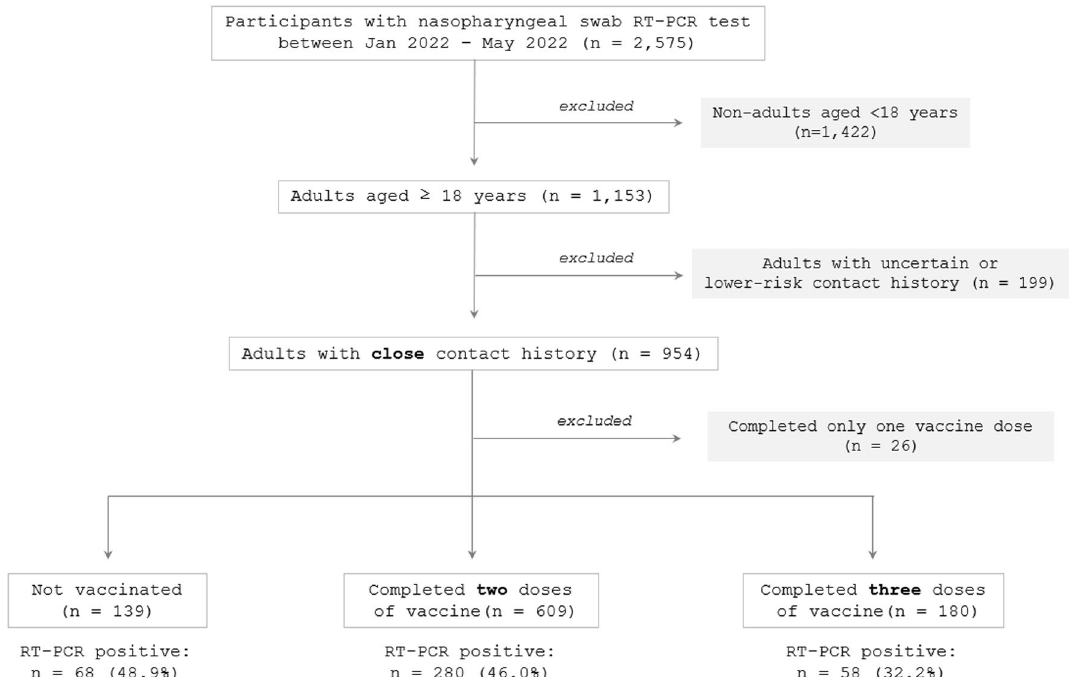
Figure 1. Flow diagram of the study design. Among the overall individuals tested by reverse transcription- polymerase chain reaction (RT-PCR) test using nasopharyngeal swab samples at a large screening test center in Japan between January and May 2022, (1) adults aged < 18 years, (2) those without a certain contact history, (3) those who had completed only one vaccine dose, and (4) those who were less than 7 days after the last vaccination were excluded. Consequently, 767 adults were eligible for subsequent